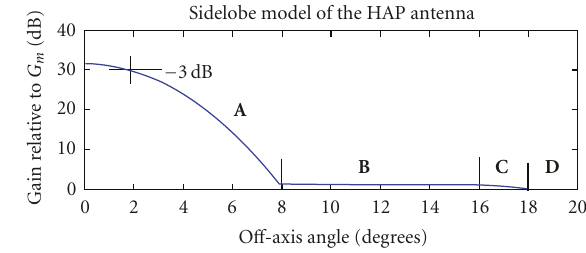
Figure 2: Radiation pattern envelope